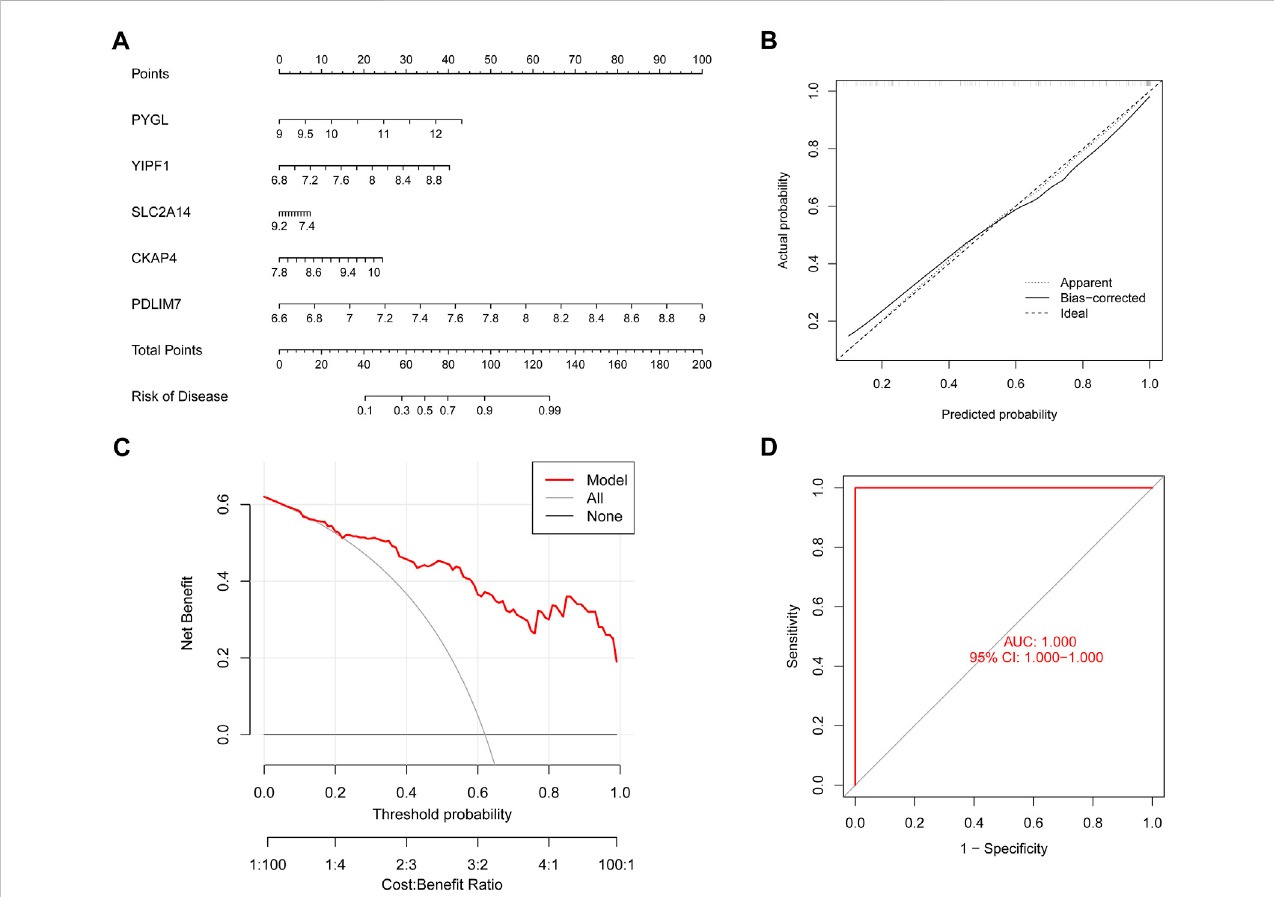
FIGURE 9 Validation of the fi ve gene-based SVM model. (A) Construction of a nomogram for predicting the risk of ER stress clusters based on the fi ve gene-based SVMmodel. (B) CalibrationcurveoftheSVMmodel. (C) DCAcurveoftheSVMmodel. (D) ROCanalysisoftheSVMmodelbasedon fi ve-foldcross-validationin the GSE108756